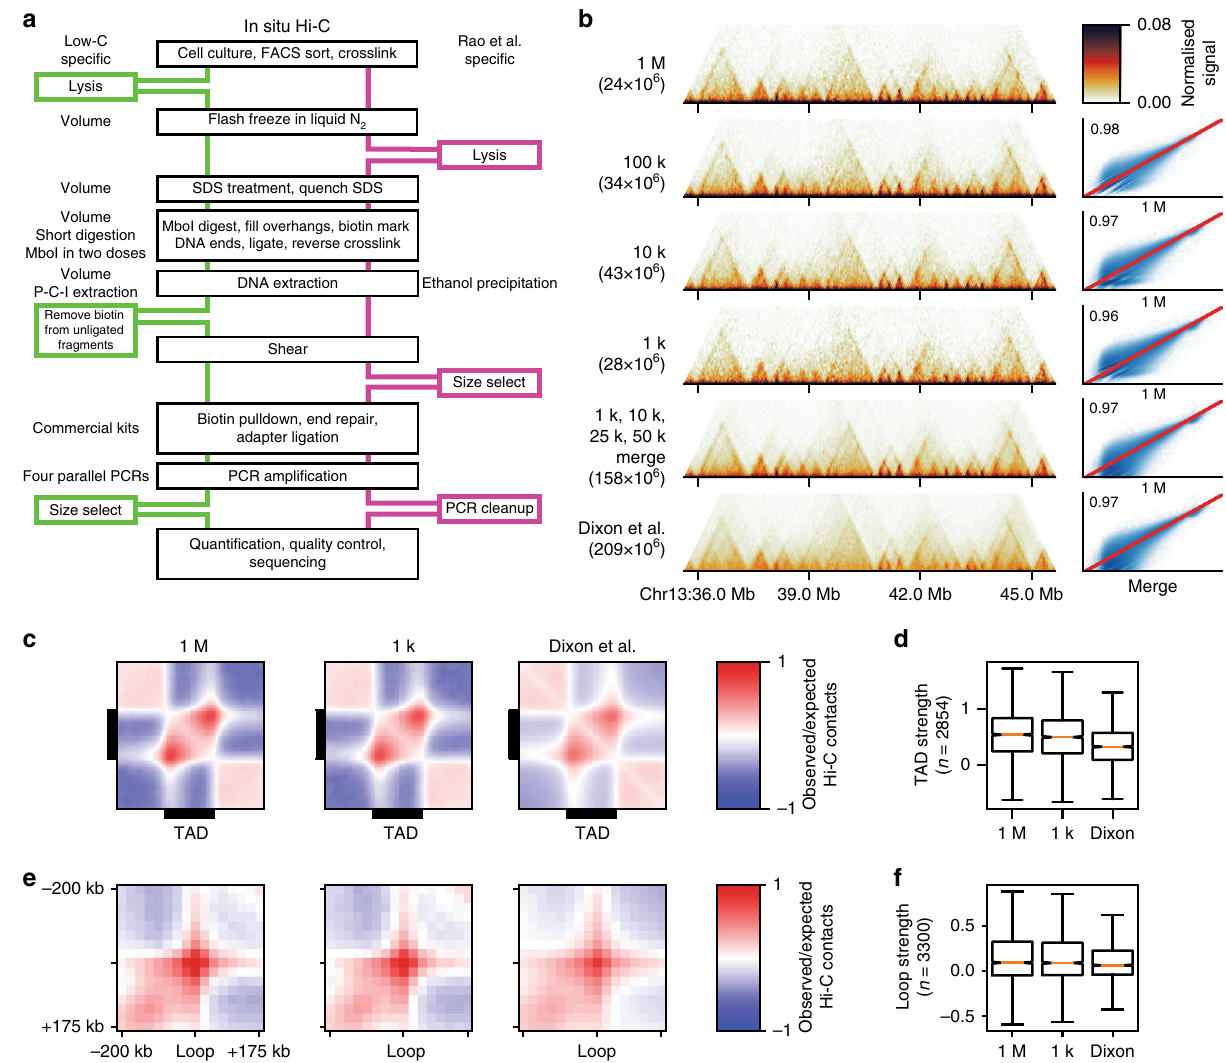
Fig. 1 Low-C enables the examination of chromatin architecture for samples with low amounts of input material. a Schematic overview of the Low-C protocol and comparison with the previously published in situ Hi-C protocol from Rao et al. 5 . Black boxes denote common steps in both protocols. Green and magenta boxes denote additional steps in the Low-C and in situ Hi-C protocol, respectively. Italicised text marks protocol-speci fi c differences regarding the step next to it. (P – C – I = Phenol – Chloroform – Isoamyl alcohol). b Low-C matrices for a 10 Mb region on chromosome 13. Input cell numbers for the Hi-C matrices shown span four orders of magnitude (1 M to 1 k cells). Pixel intensity corresponds to normalised counts. The bottom two Hi-C matrices display data from a merge of Low-C samples (1 k, 10 k, 25 k, and 50 k), and a previously published ESC dataset from Dixon et al. 15 with similar sequencing depth as the merged sample. In brackets below the sample label, we list the number of valid read pairs in each Hi-C library. Next to the Hi-C matrices scatter plots and Pearson correlation coef fi cient of the contact intensities in the 50 kb resolution maps of each sample on the left against the 1 M sample are shown. The correlation and scatter plots next to the Dixon et al. 15 dataset correspond to a comparison with the merged sample. Red line indicates identity. c Aggregate TAD analysis of the 1 M, 1 k, and Dixon et al. 15 Hi-C maps. Shown is the average observed/expected ratio of Hi-C signal for regions around all TADs as determined by Rao et al. 5 . d Comparison of TAD strength (Methods) for the 1 M, 1 k, and Dixon et al. 15 samples. e Aggregate loop analysis showing the average observed/expected Hi-C signal at all loop regions as determined by Rao et al. 5 . f Comparison of loop strength (Methods) for the 1 M, 1 k, and Dixon et al. 15 samples. d , f Boxes span the interquartile range (IQR), i.e. they extend from the fi rst (Q1) to the third quartile (Q3) values of the data, with a line at the median. Whiskers span [Q1 − 1.5 × IQR, Q3 + 1.5 × IQR], outliers are